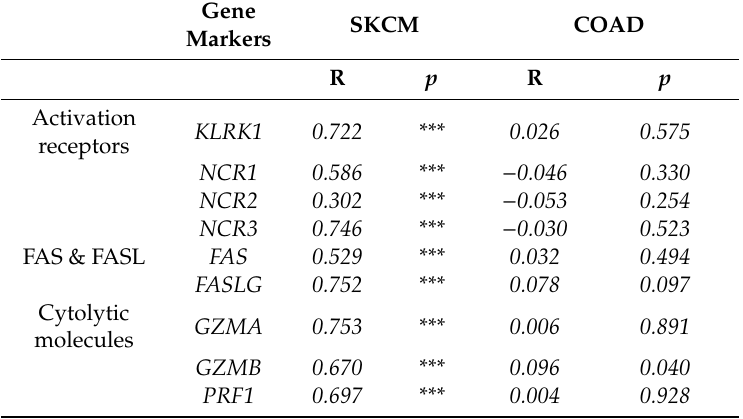
Table 3. Correlation between Ly75 and NK activation signature genes using